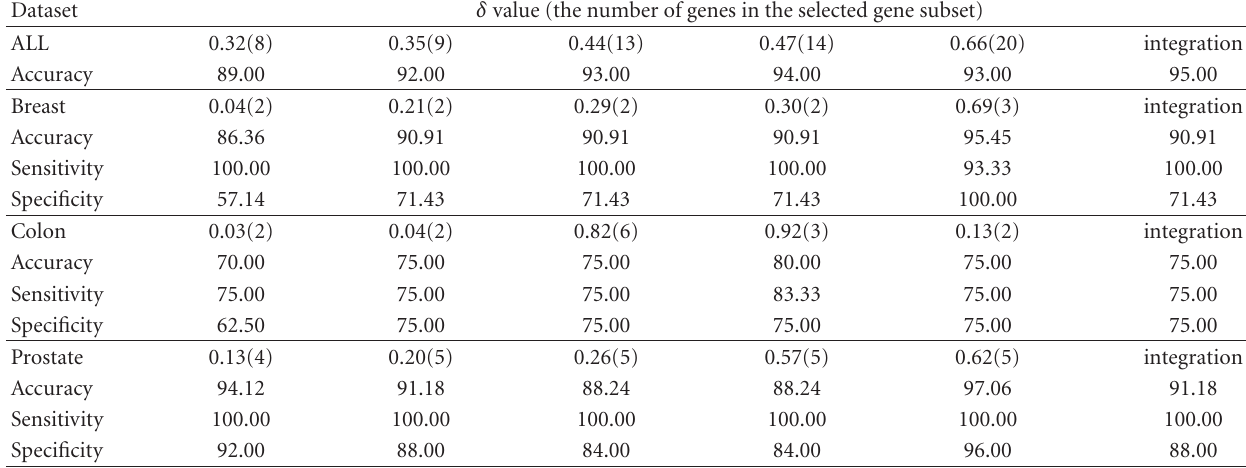
Table 2: Classification accuracy, sensitivity and specificity on all the test datasets by the ensemble classifier.